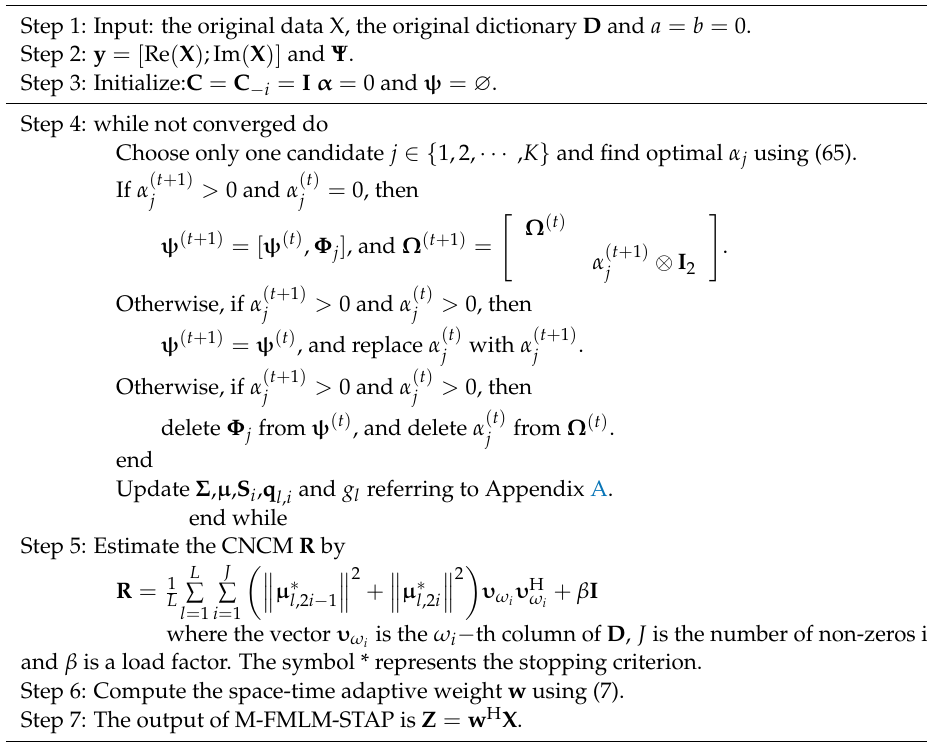
Algorithm 2: Pseudocode for M-FMLM-STAP